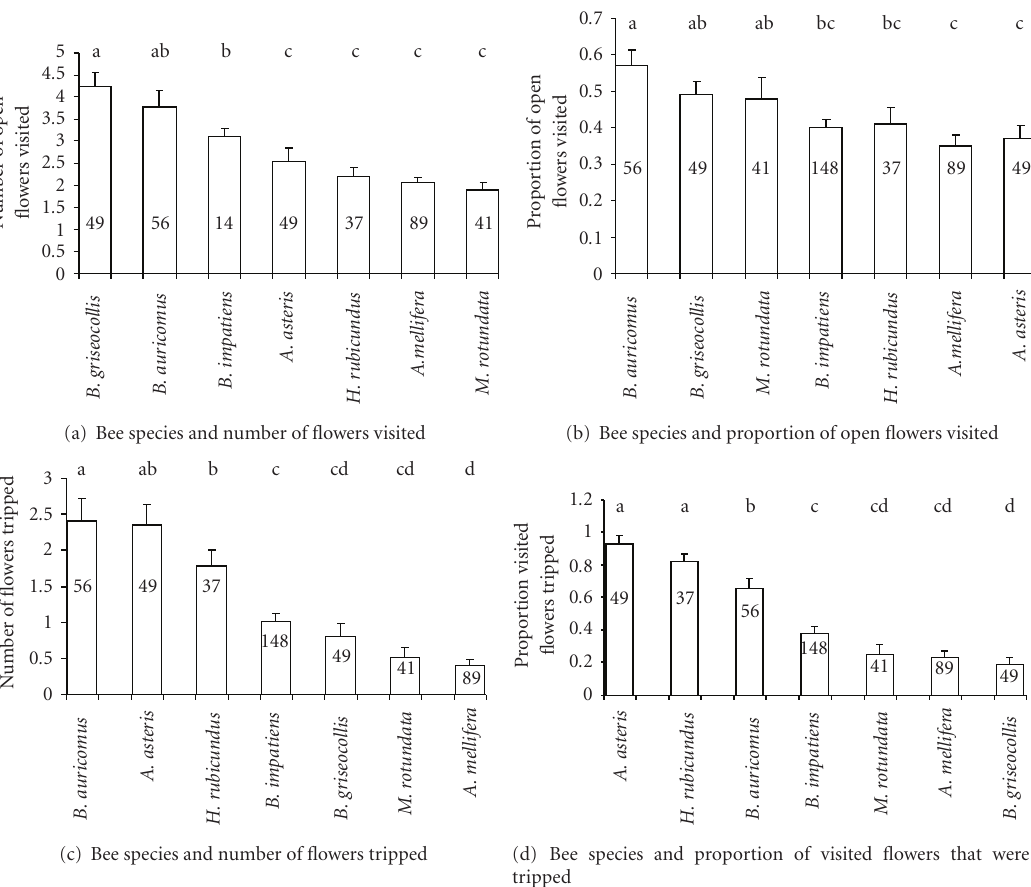
Figure 1: The impact of bee species on (a) the number of flowers visited per raceme; (b) the number of flowers tripped per raceme; (c) the proportion of open flowers that were visited per raceme; (d) the proportion of visited flowers that were tripped per raceme. The numbers inside each column represent the sample sizes while di ff erent letters indicate a statistically significant di ff erence between bee species as determined by the Duncan’s multiple range test.